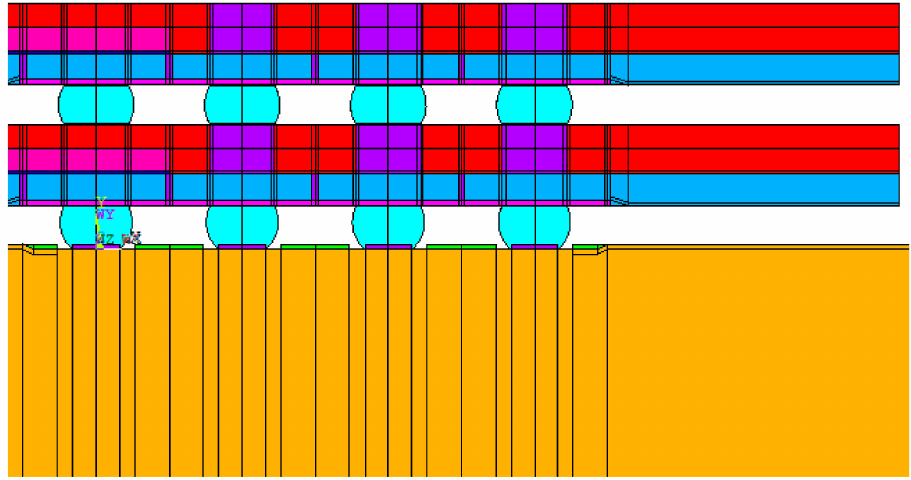
Figure 8. 2D finite element model of the stacked FO-WLP (i.e., packaging-on-packaging